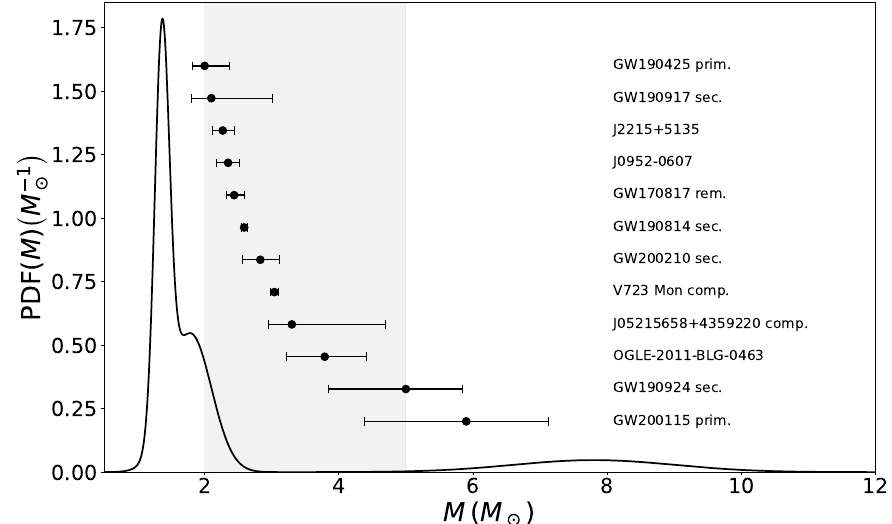
Figure 12. Mass distribution and gap object candidates from [29]. The solid line shows the mixture of the BH mass distribution from [24] and the NS mass distribution from [61]. In addition, shown are the mass measurements, with their 1 σ confidence intervals, of the 12 gap candidates the authors consider, a mix of Galactic and extragalactic